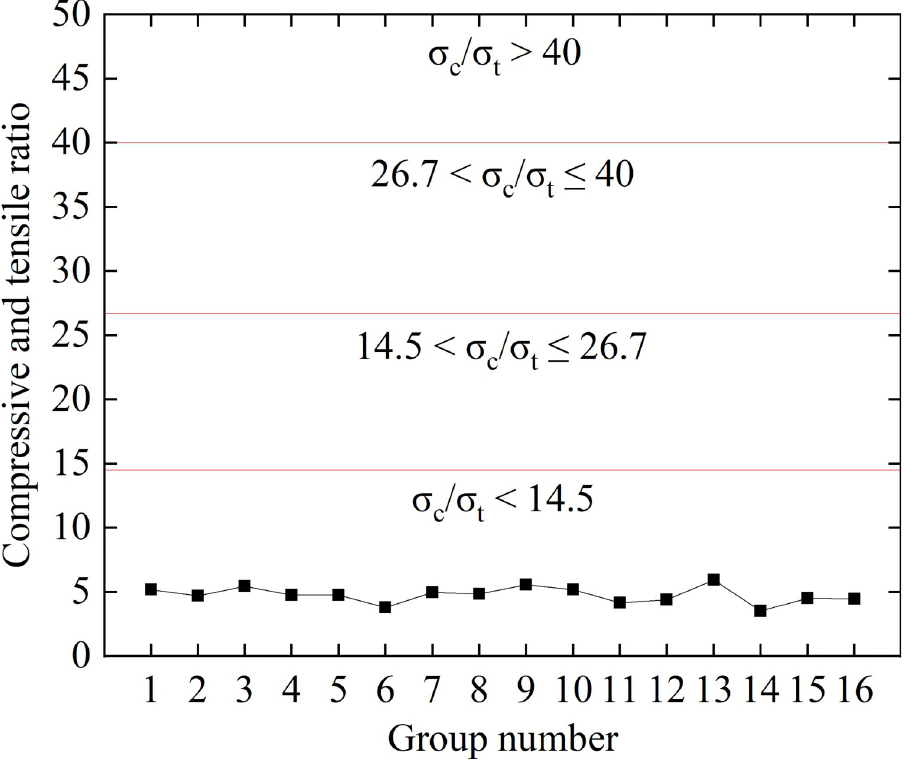
Fig 6. Evaluations of rockburst tendencies based on compression and tensile